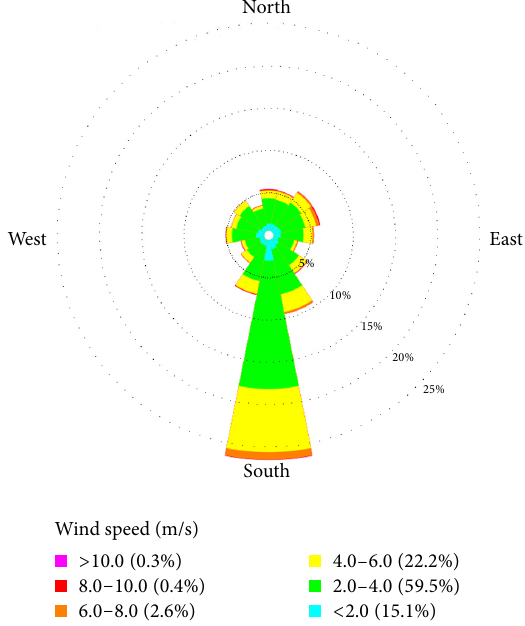
Figure 12: Polar diagram: wind direction for Sarh.